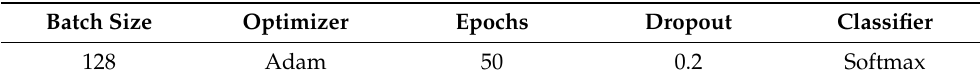
Table 3. The used